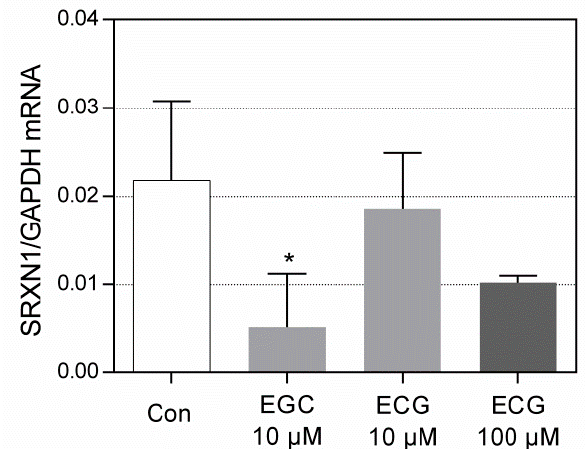
Figure 6. Downregulation of SRXN1 following increased DNA methylation is induced only by ( − )-epigallocatechin (EGC). Changes in mRNA expression level estimated by RT-qPCR for SRXN1 gene after 24 h treatment of HT29 cells with 10 µM EGC, 10 µM, and 100 µM ( − )-epicatechin gallate (ECG). The results are means ± SD of three biological replicates. Statistical analysis was carried out by one-way ANOVA with Dunnett’s test; (*)— p -value ≤ 0.05. Con refers to control